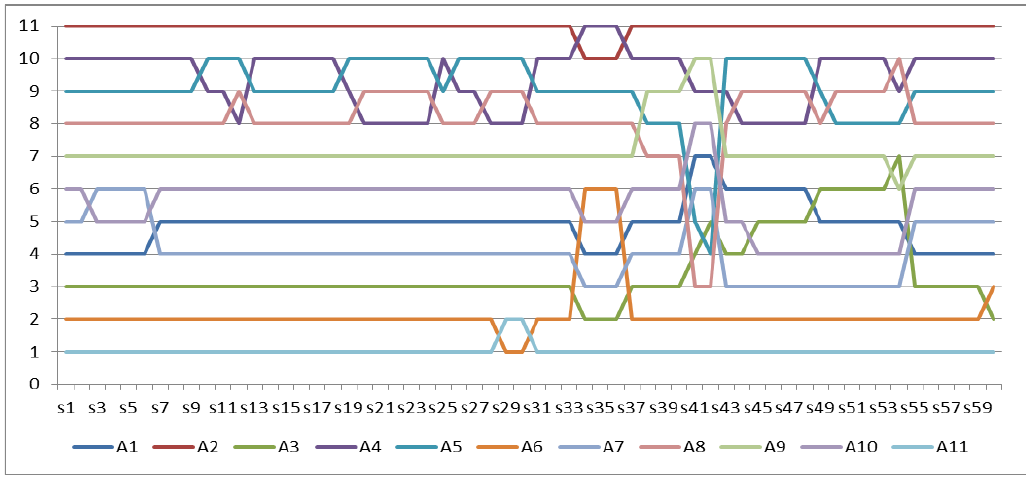
Figure 1. The sensitivity analysis ’ s results.